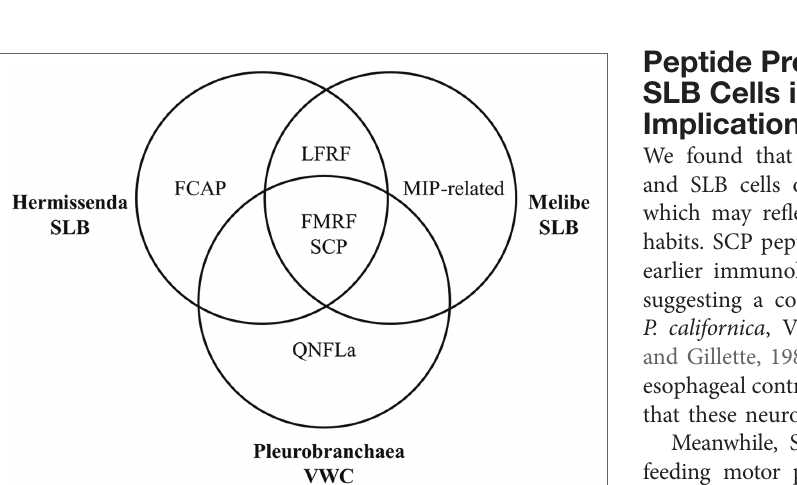
FIGURE 4 | Representative MALDI-TOF MS spectrum from a Pleurobranchaea californica VWC. Five neurons were analyzed. In addition to the previously described peptides from the FMRFa and QNFLa prohormones (Green et al., 2018), the VWC expressed both SCP A and SCP B .